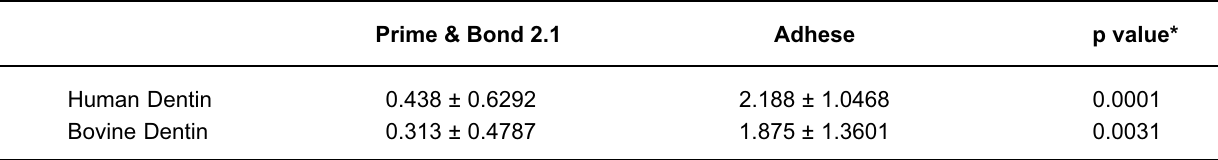
* Mann-Whitney U test (p< 0.05). TABLE 4- Mean of microleakage and standard deviations for the interaction between the adhesive systems